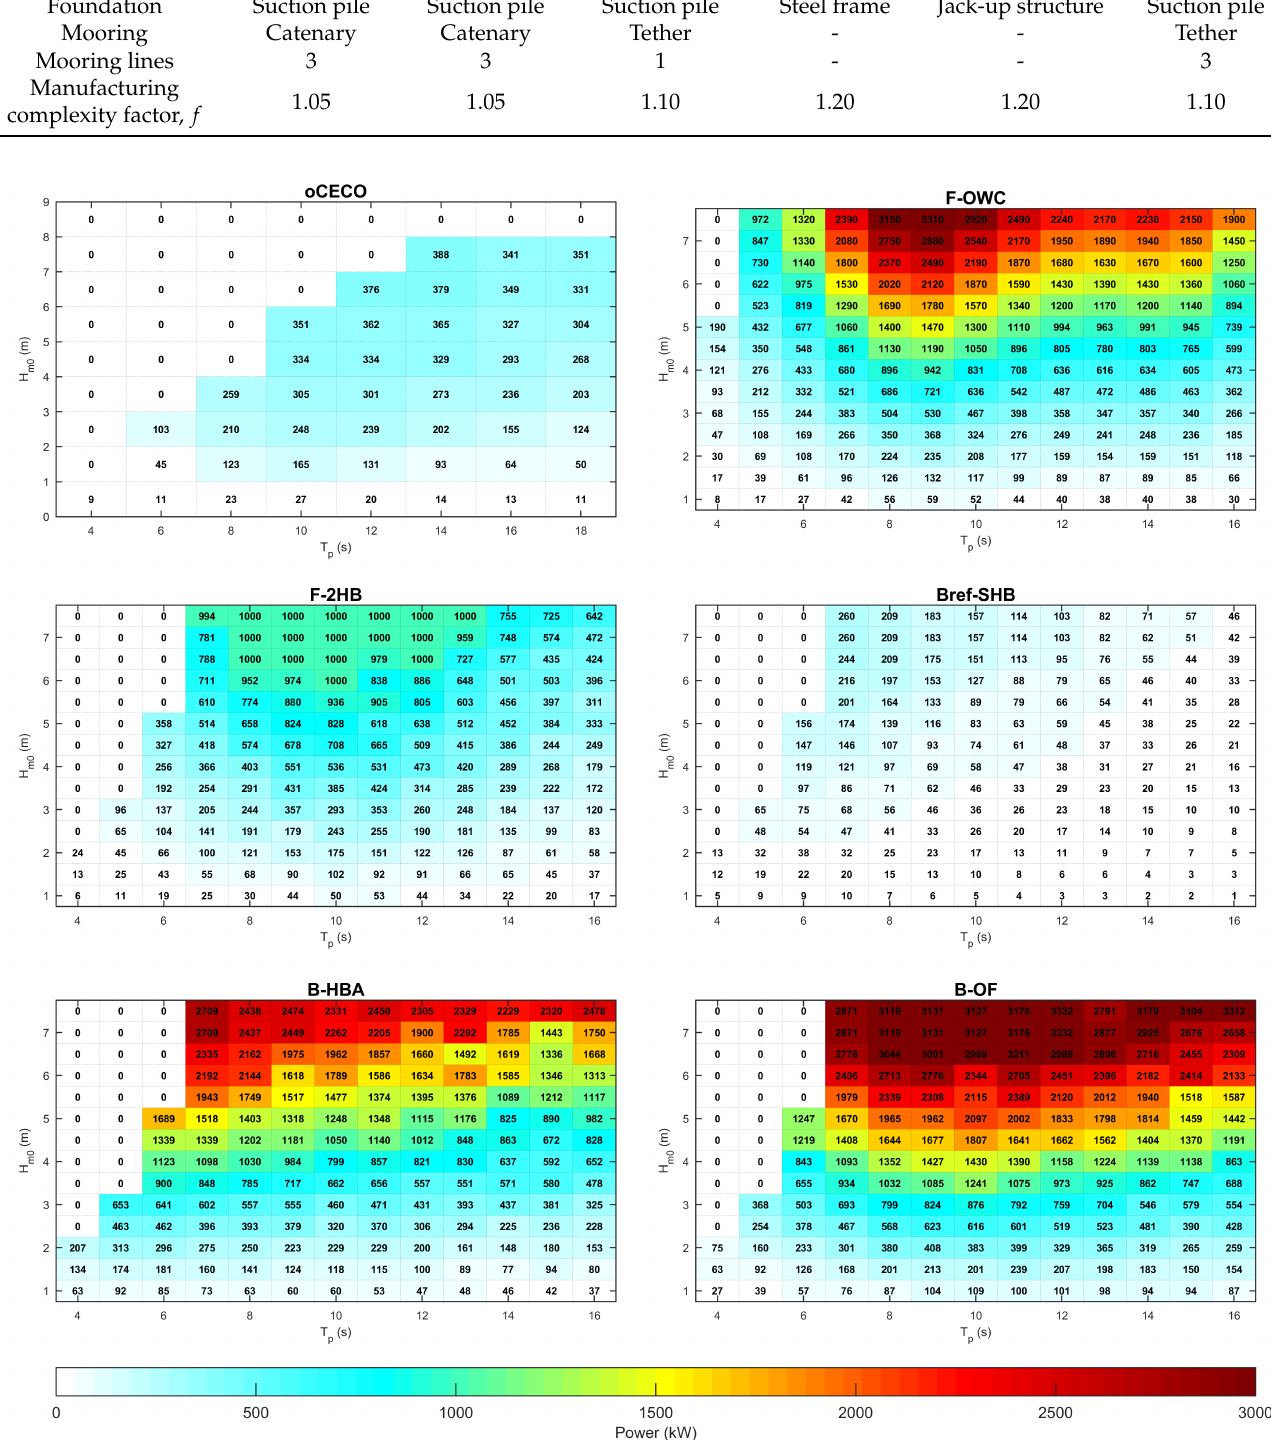
Figure 5. Wave power matrices of the case-study WECs (Numbers represent the mean power production for each sea-state bin. Colourmap represents the power produced for the different sea